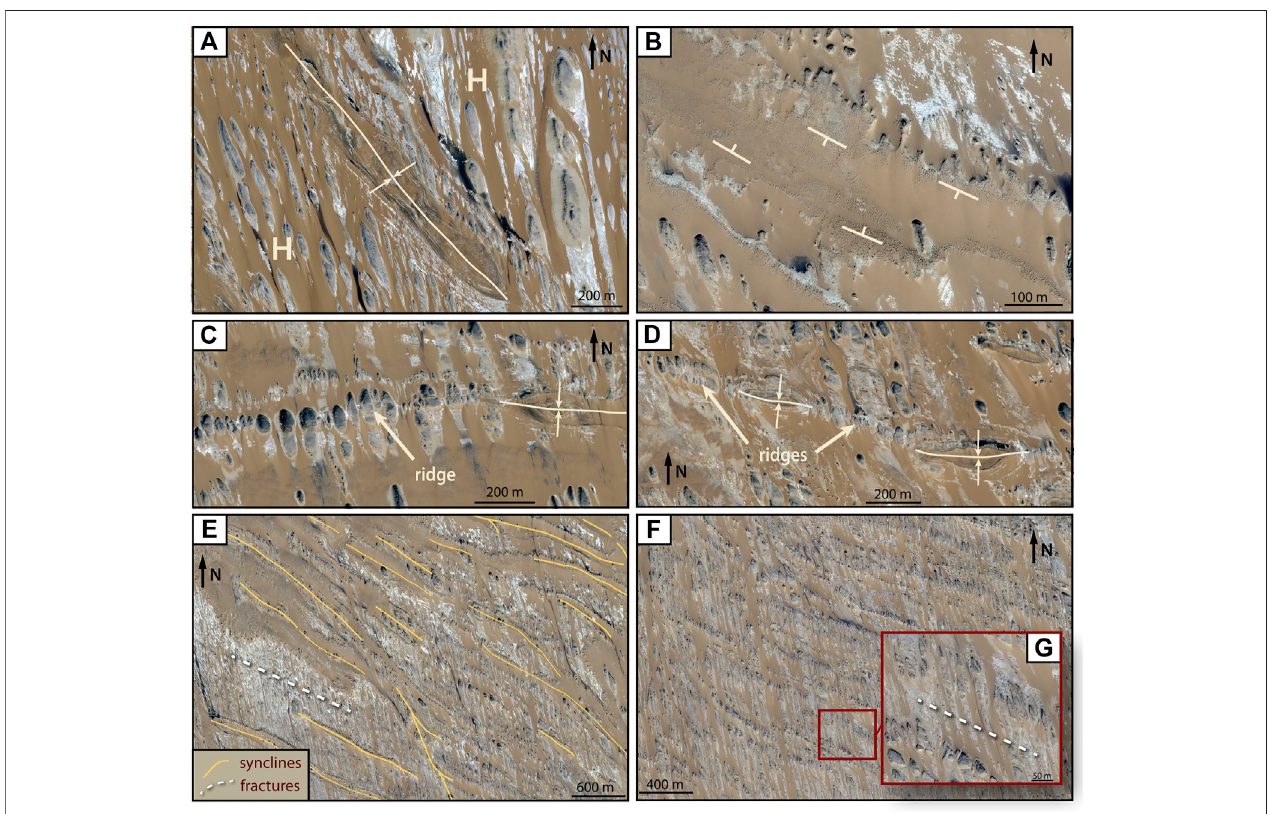
FIGURE11| Synclinesand ridges inthe panels. (A) Synclinewith typical “ stripe-and-eye ” pattern inotherwisehorizontallimestone (H) characterized byyardangs. (B) Subtle syncline indicated only by shallow inward dip slopes in pale brown siliceous limestone layer. (C) Syncline continuing on trend as a ridge. (D) Small elongate basinsconnectedbyridges. (E) WNW – ESEtoNW – SEsynclinetrendsincentralpartofpanelB. (F) WNW – ESEtoNW – SEridgetrendsinpanelB10 kmsouthof (E) . (G) Ridges and synclines are parallel to prominent fracture set (white dashes in E,G ). Satellite imagery source: Google Earth. Coordinates for Google Earth images: A) 26.276997, 30.393522; B) 26.287539, 30.504026; C) 26.297358, 30.648197; D) 26.313914, 30.492954; E) 26.275627, 30.502326; F) 26.187253,